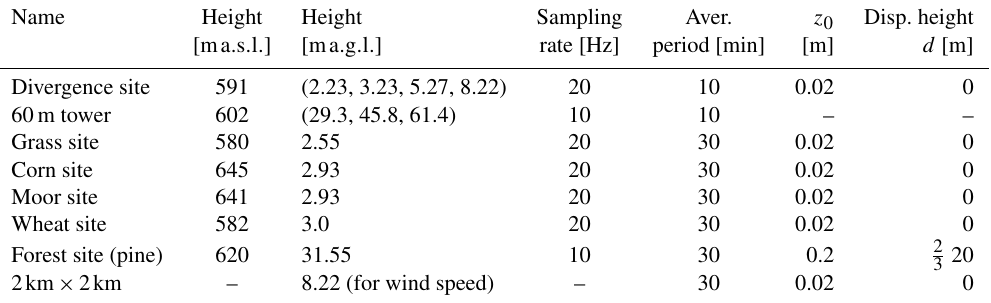
Table 1. Brief description of BLLAST measurement sites and data sets with the required buoyancy flux, winds and temperature for the modeling of TKE. Also listed are the roughness length ( z 0 ) and displacement height ( d ) values in the model. For additional details see Lothon et al.